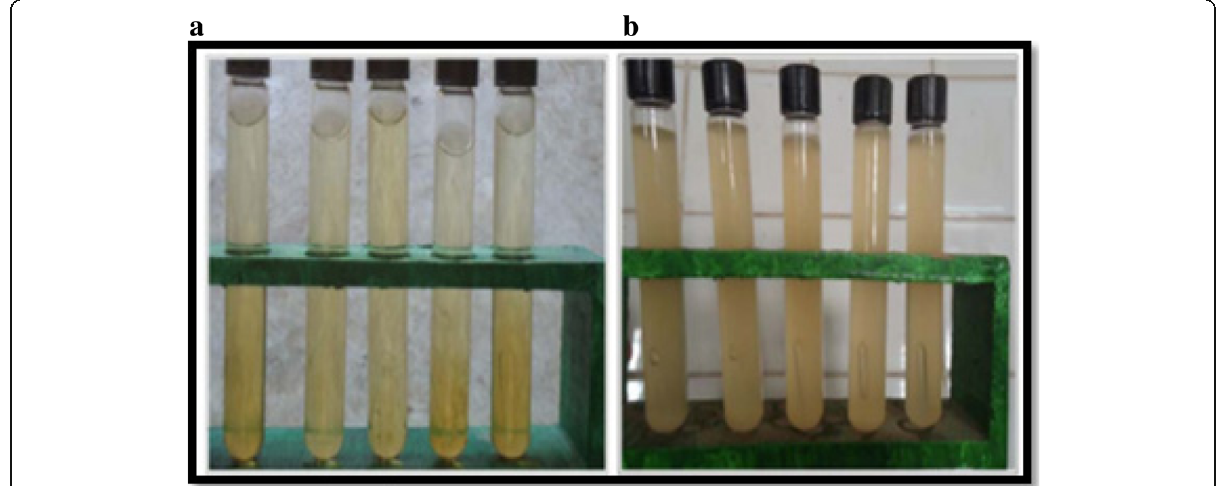
Fig. 5 a Negative lauryl tryptose broth tubes for coliform. b Positive presumptive